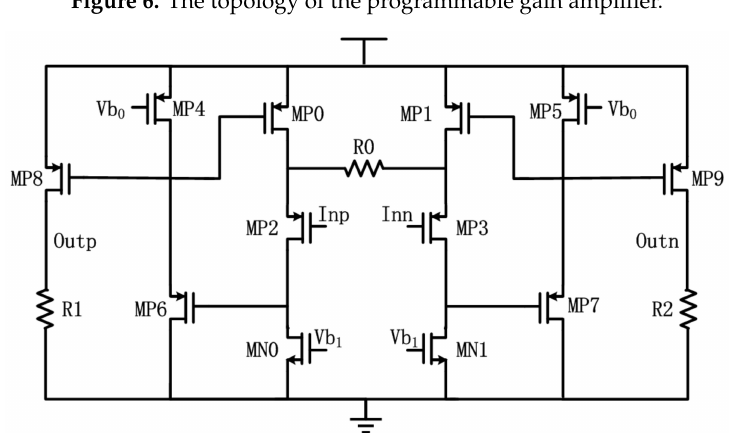
Figure 7. The circuit schematic of the fixed-gain